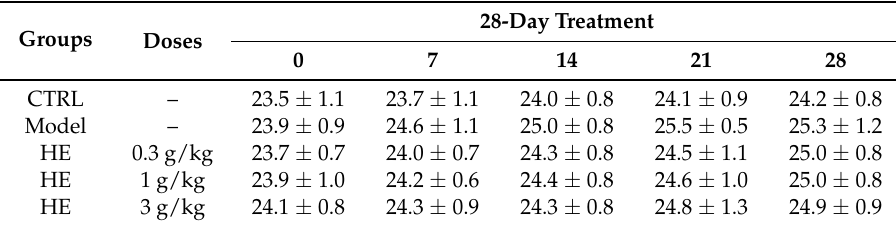
Figure 4. In AlCl 3 - and D -gal-induced AD mice, four-week HE treatment strongly enhanced ( A ) horizontal movements and ( B ) vertical movements in locomotor activity test; ( C ) increased the endurance time in rotating test; and ( D ) reduced the escape latency time in water-maze test compared with nontreated model mice. Data are expressed as mean ± SD ( n = 10). ### p < 0.001 vs. normal mice (CTRL), ** p < 0.01 and *** p < 0.001 vs. AD mice. HE: Hericium erinaceus aqueous extract. Table 1. The effects of HE on bodyweights in Alzheimer’s disease mice.